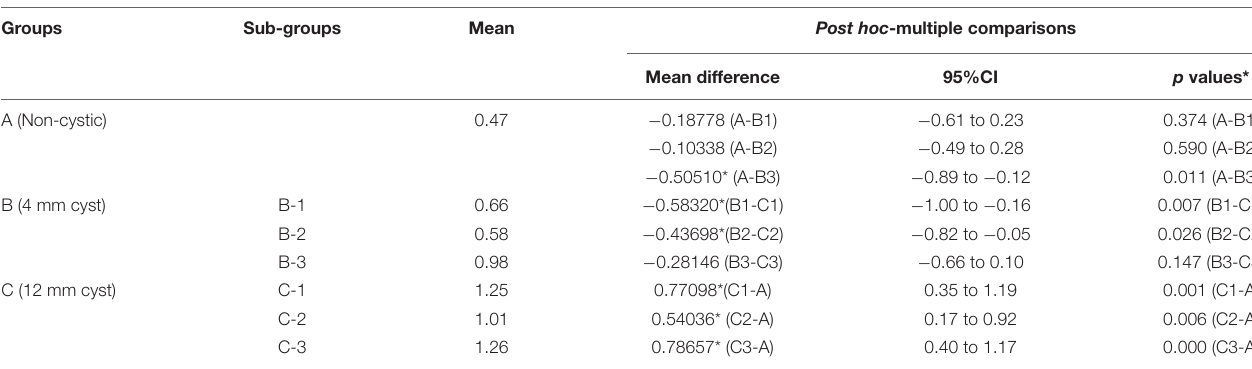
FIGURE 6 | (a) Articular cartilage shear stress changes in groups A, B, and C with associated sub-groups 1, 2 and 3. (b) Graphical representation of mean cartilage stress during double and single-leg stance. TABLE 4 | Statistical analysis of cartilage stress in various